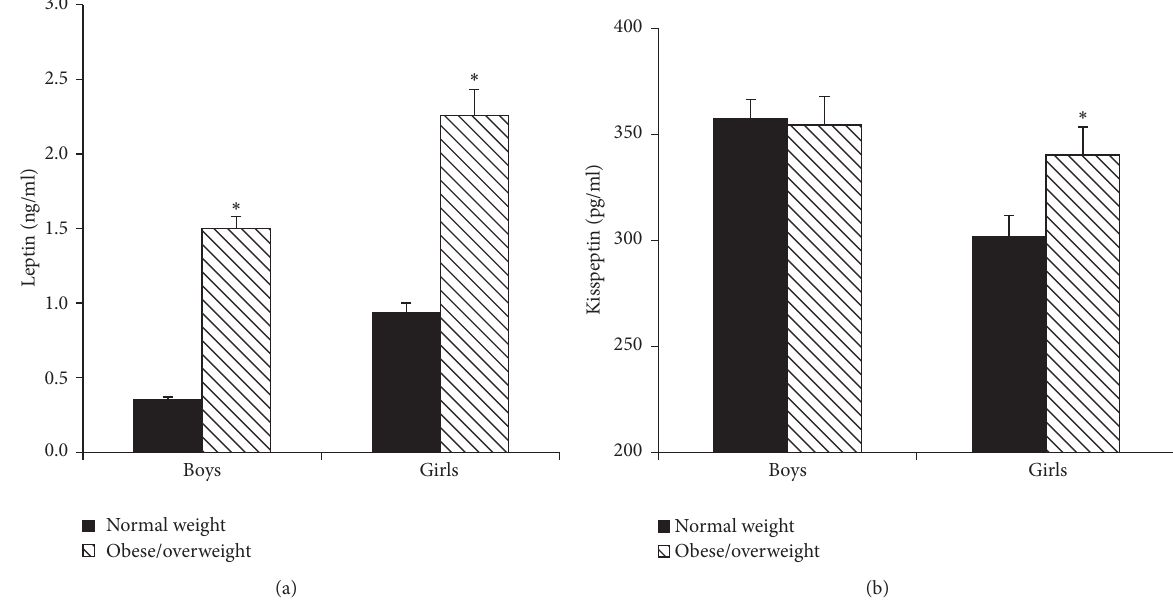
Figure 6: Serum leptin (a) and kisspeptin (b) levels between normal weight and obese/overweight children ((a) ∗ compared with normal weight children, 𝑃 < 0.01 ; (b) ∗ compared with normal weight children, 𝑃 < 0.05 ).